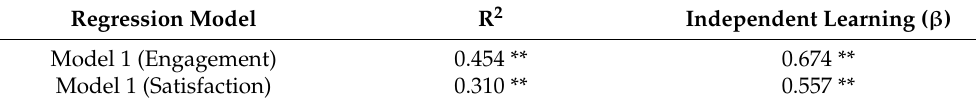
Table 4. Regression results: independent learning predicting engagement and satisfaction. Regression Model R 2 Independent Learning ( β ) Model 1 (Engagement) 0.454 ** 0.674 ** Model 1 (Satisfaction) 0.310 ** 0.557 ** ** p <